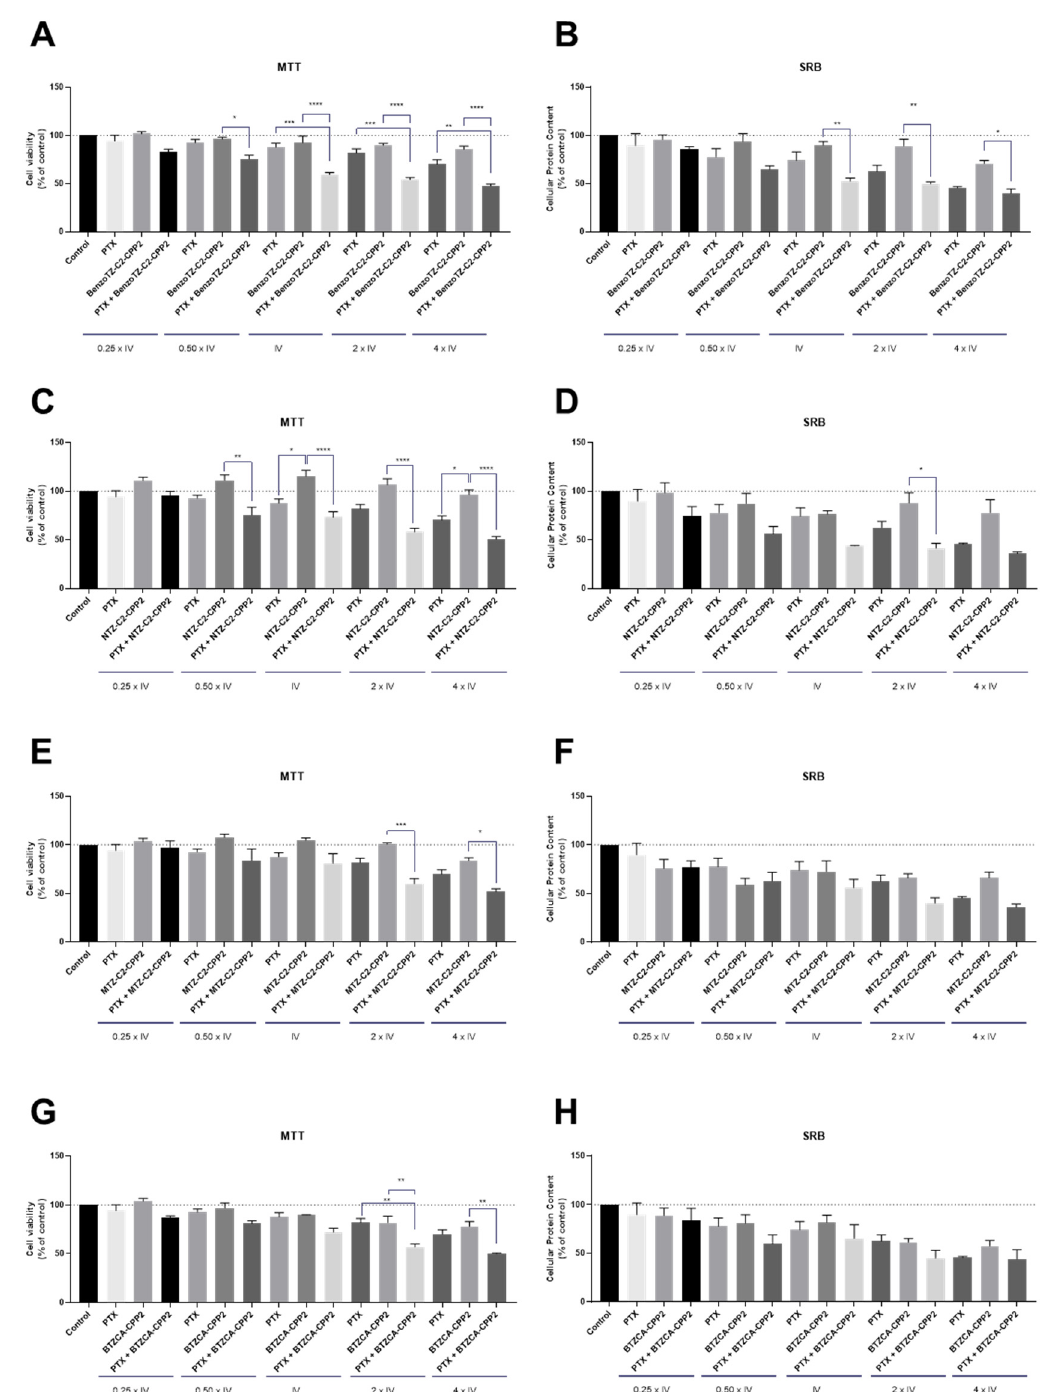
Figure 6. Cytotoxic effects of the combination of PTX with ( A , B ) BenzoTZ-C2-CPP2, ( C , D ) NTZ-C2-CPP2, ( E , F ) MTZ-C2- CPP2 and ( G , H ) BTZCA-CPP2 on the viability (right panel) and cell protein (left panel) content of PC-3 cells. Cell viability and protein content were assessed by MTT and SRB assays, respectively, after 48 h of exposure to each treatment. Results are expressed in the percentage of cell viability relative to untreated control cells. *, **, *** and **** indicate p < 0.05, p < 0.01, p < 0.001 and p < 0.0001, respectively, when compared to the control. All data are presented as the mean ± SEM of three independent experiments.